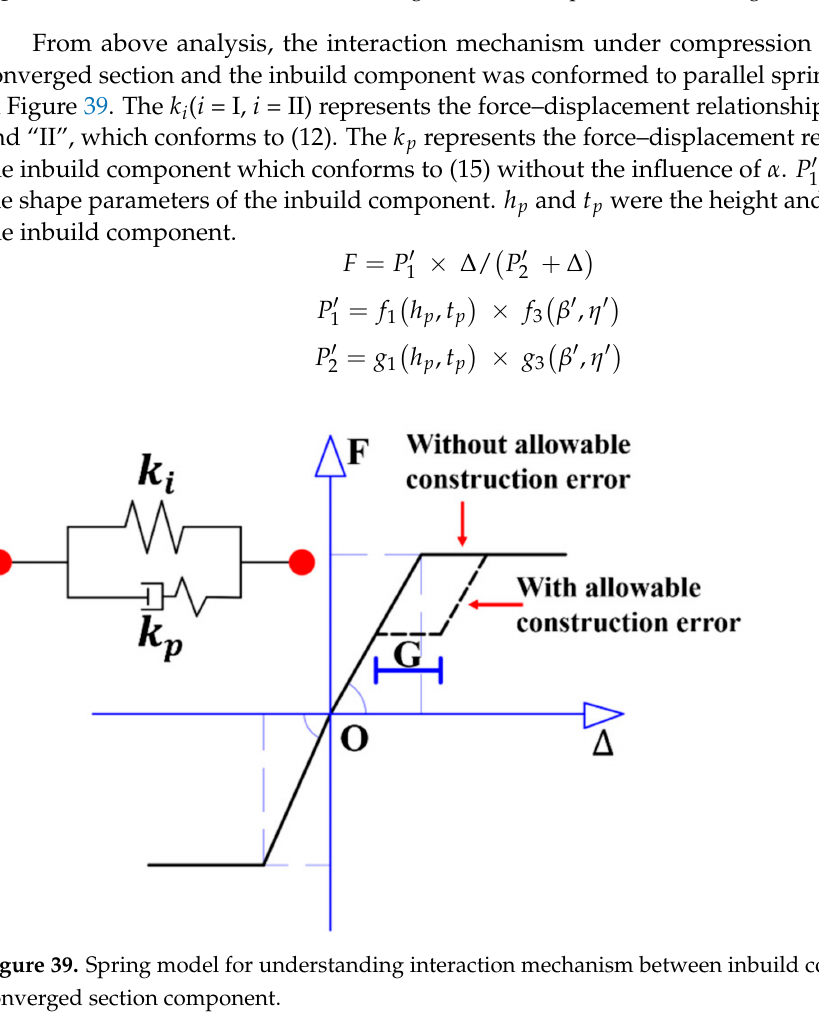
Figure 38. The deformation mode of converged section component considering construction errors.